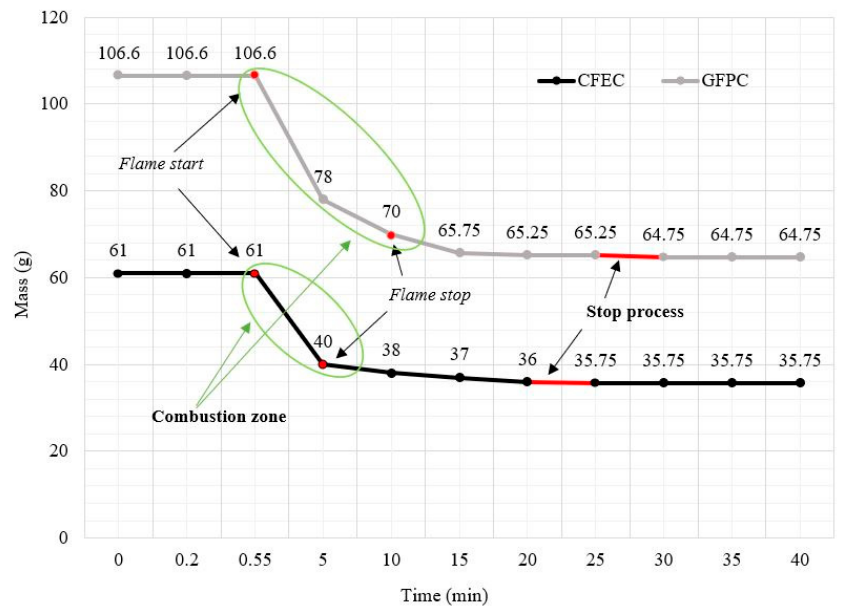
Figure 6. The relationship between mass (g) and time (min).